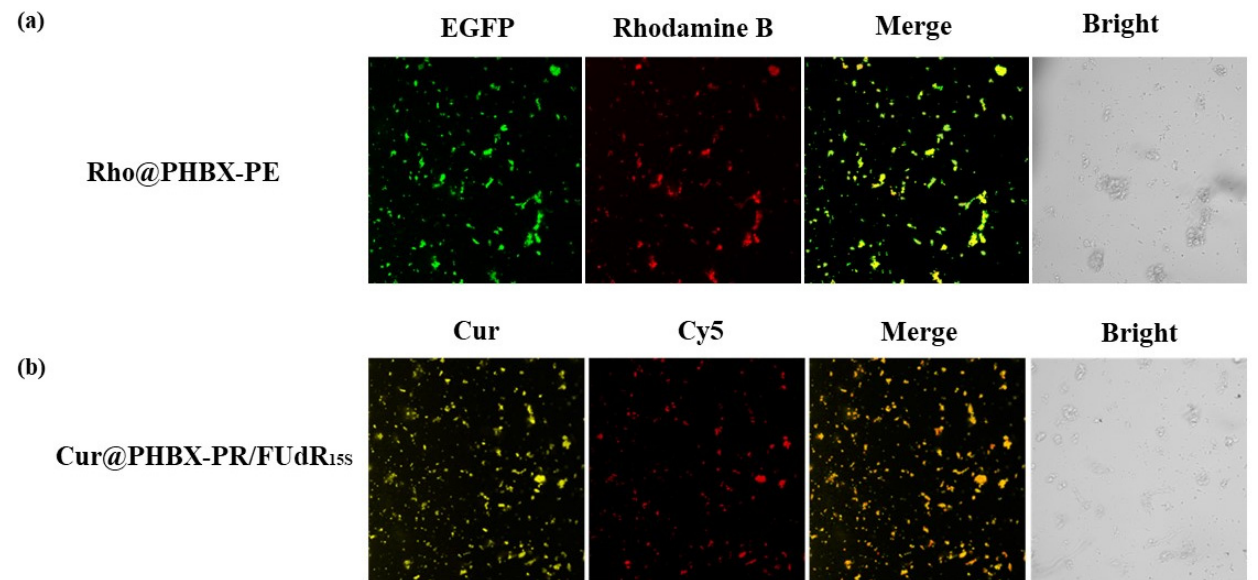
Figure 1. The assembly verification of PHA nanosphere Rho@PHBX-PE and Cur@PHBX-PR/FUdR 15S by laser confocal microscopy. ( a ) The Rho emitted red fluorescence, the EGFP produced green fluorescence, and the successfully assembled nanosphere showed yellow fluorescence. ( b ) The self-assembly of Cur@PHBX-PR/FUdR 15S showed orange fluorescence by overlapping the yellow fluorescence of Cur and red fluorescence of Cy5-labeled FUdR 15S .